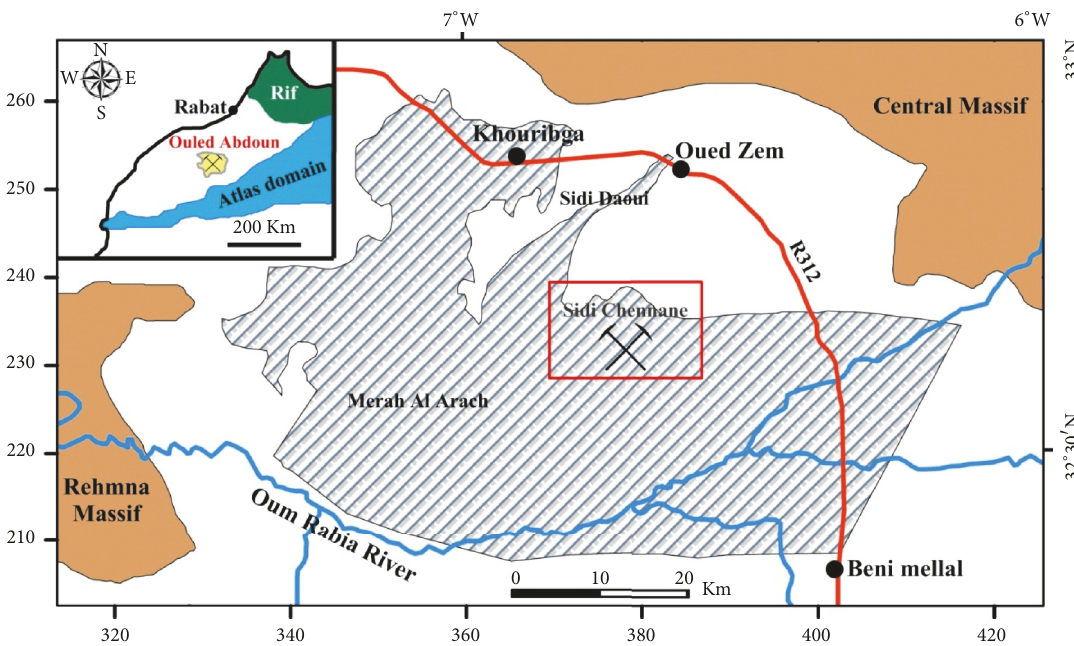
Figure 1: Geographical location of Sidi Chennane mine in the sedimentary basin of Ouled Abdoun.